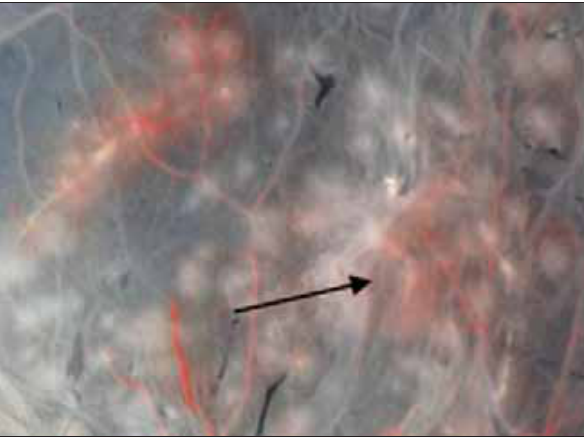
Figure-3: More distinct pocks were produced by field strain of fowl pox virus on chorioallantoic membrane at fourth passage level.